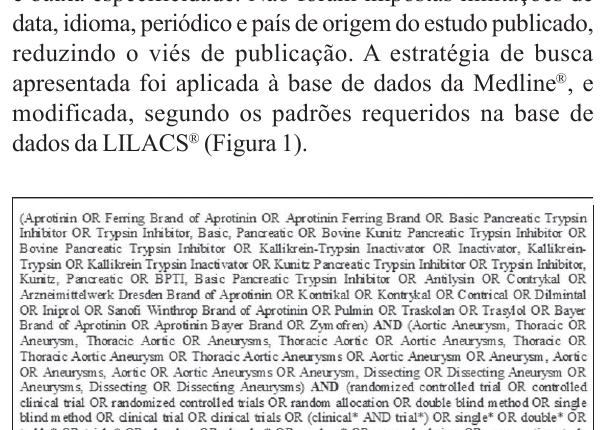
Métodos padronizados de revisão